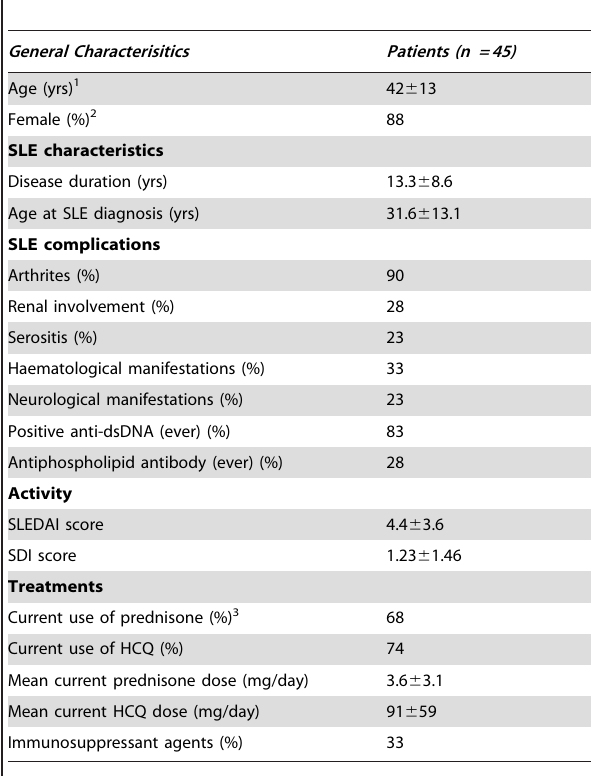
Table 1. Main characteristics of study subjects with systemic lupus